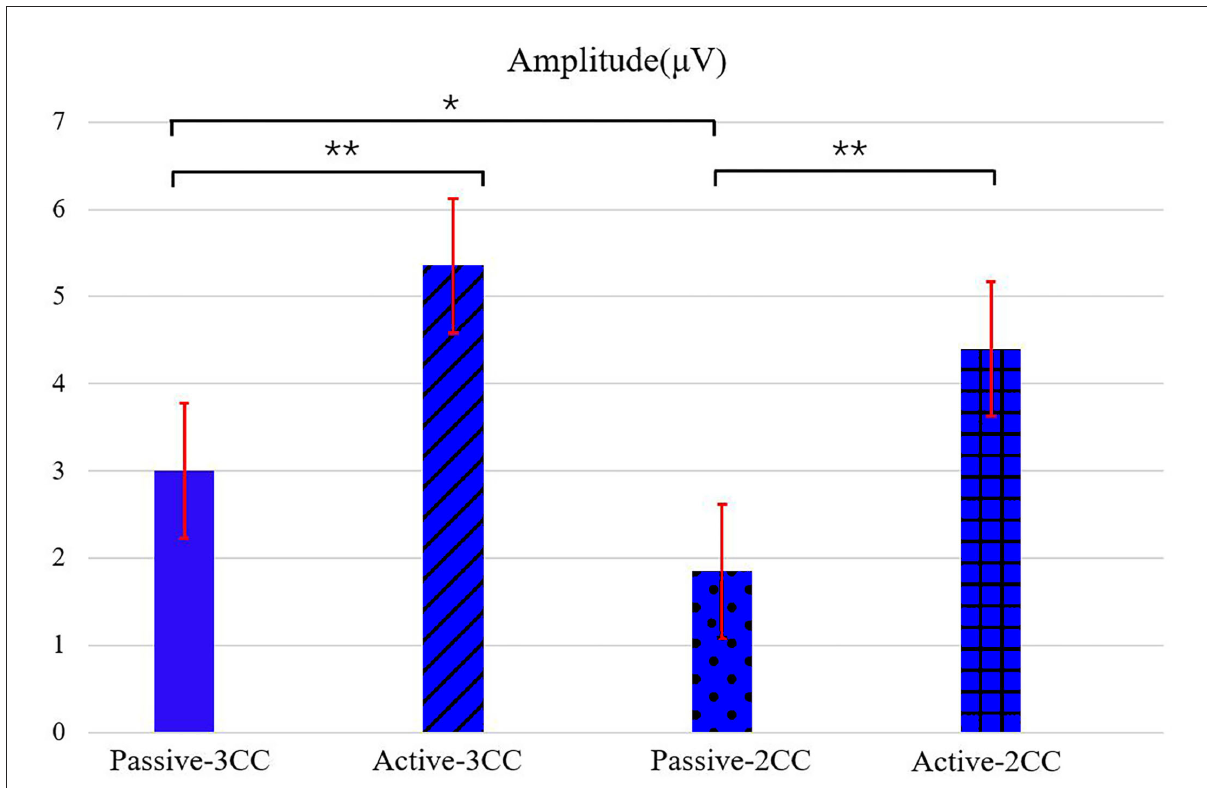
FIGURE4 ERP amplitudes in the second time intervals (which indicated the P300 component) evoked by target stimuli in both passive and active conditions with different types of non-target stimuli. The a-black solid asterisk indicates a significant difference ( p < 0.05) between two conditions, and the two-black solid asterisks indicate a very significant difference ( p < 0.01) between two conditions. Values are the means and standard error (Mean SE) of P300 amplitude among an average of 12 ±